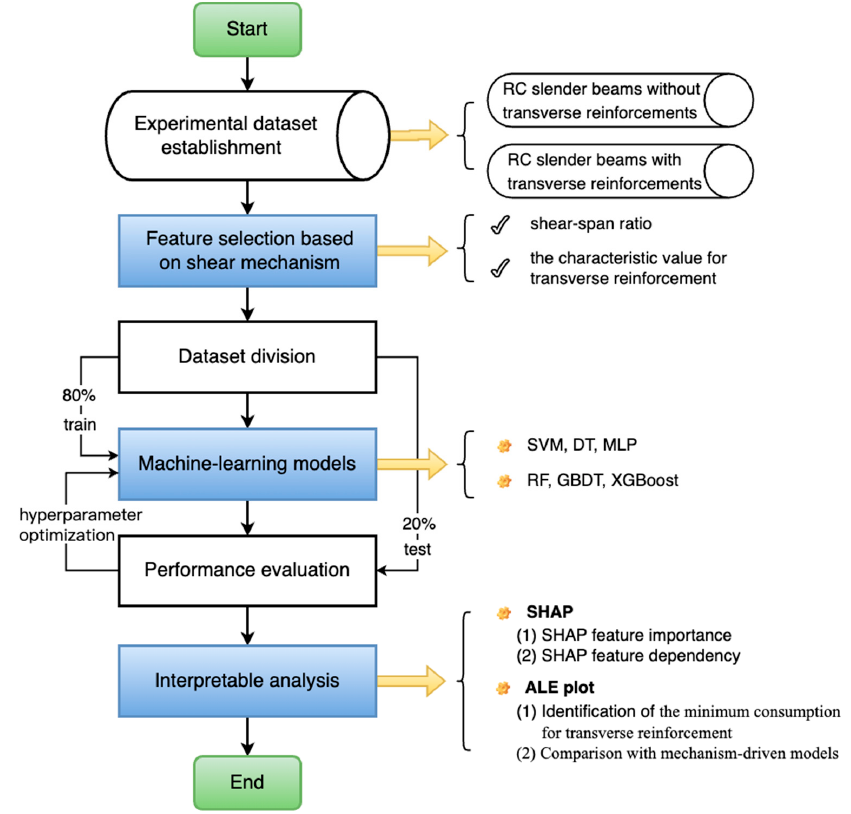
Figure 1. The research process diagram of this paper.